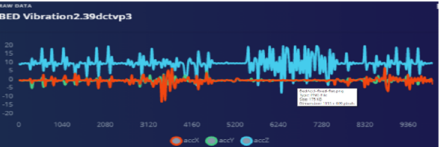
Figure 18. Bed vibration with fixed sensor.